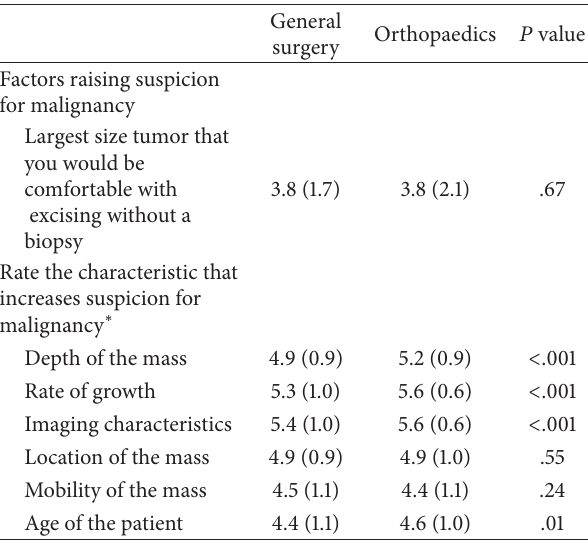
Table 3: Residents’ rating of characteristics that increase suspicion for